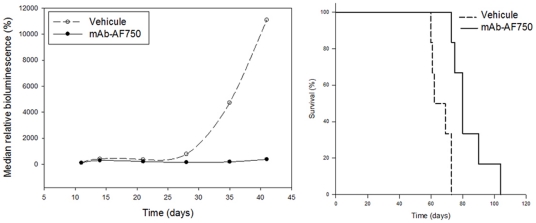
Effects of fluorescent CD44 mAb intravenously administered over three weeks on the bioluminescence signal of HL60-Luc tumor-bearing mice (A) and on life span (B).